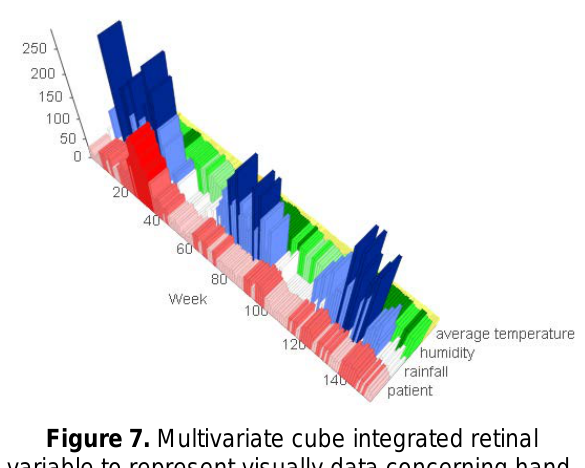
Figure 7. Multivariate cube integrated retinal variable to represent visually data concerning hand, foot, mouth disease in Binhduong province during